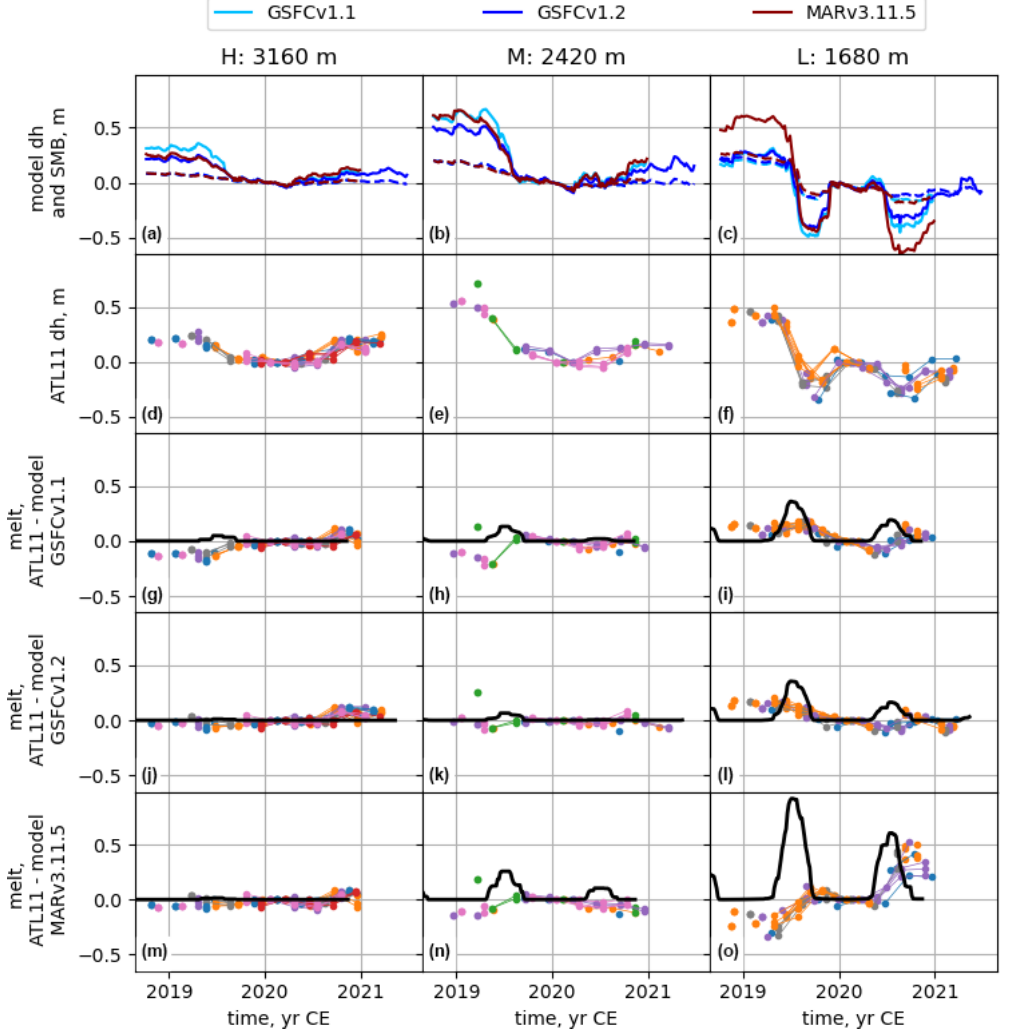
Figure 2. Data and model estimates for three locations indicated in Fig. 1. (a–c) Model total height anomalies (solid) and SMB-driven height anomalies (dashed) for all the three models. (d–f) ATL11 height time series for each location, with different colours indicating different RPTs. (g–o) Differences between ATL11 time series and total model height anomaly for each model and location. Solid black lines show a 90d running mean of the melt estimated by each model (positive indicates height lost to melt). To align the time series vertically, we subtract the value for cycle 6 (Q1 of 2020) from each. Time series for each RPT are joined by a solid line when derived from continuous repeat-track measurements. Broken lines or lone points indicate crossover measurements or missing values in the repeat-track